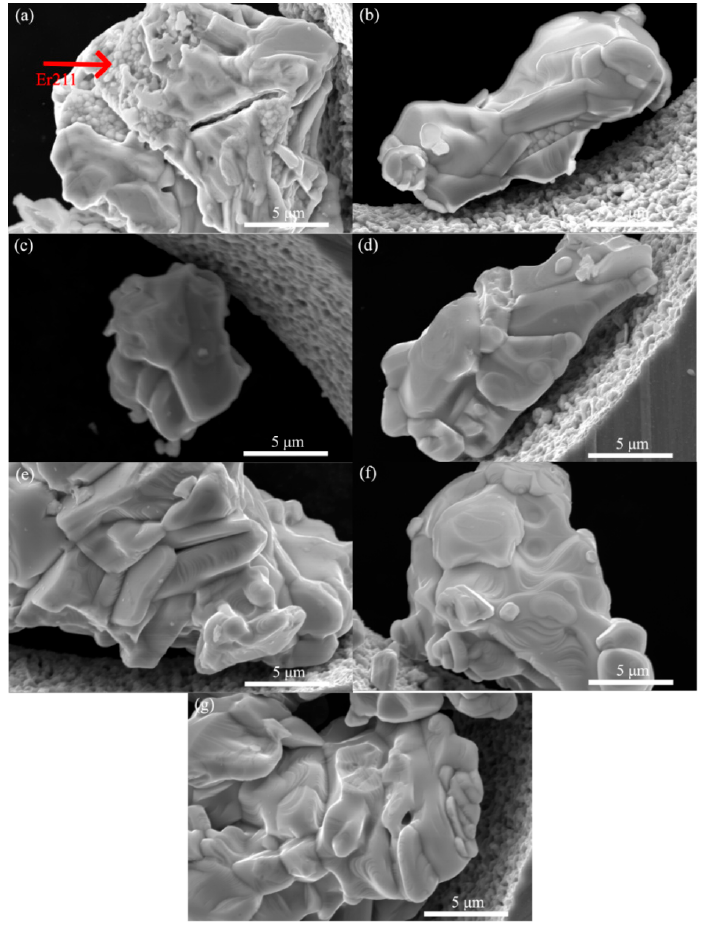
Figure 2. The SEM images of Er123 powder after different sintering. ( a ): 890 °C for 24 h; ( b ): 900 °C for 24 h; ( c ): 910 °C for 24 h; ( d ): 920 °C for 24 h; ( e ): 920 °C for 24 h (three times); ( f ): 920 °C for 24 h for 24 h; ( c ): 910 ◦ C for 24 h; ( d ): 920 ◦ C for 24 h; ( e ): 920 ◦ C for 24 h (three times); ( f ): 920 ◦ C for 24 h (four times); ( g ): 930 °C for 24 h. (four times); ( g ): 930 ◦ C for 24